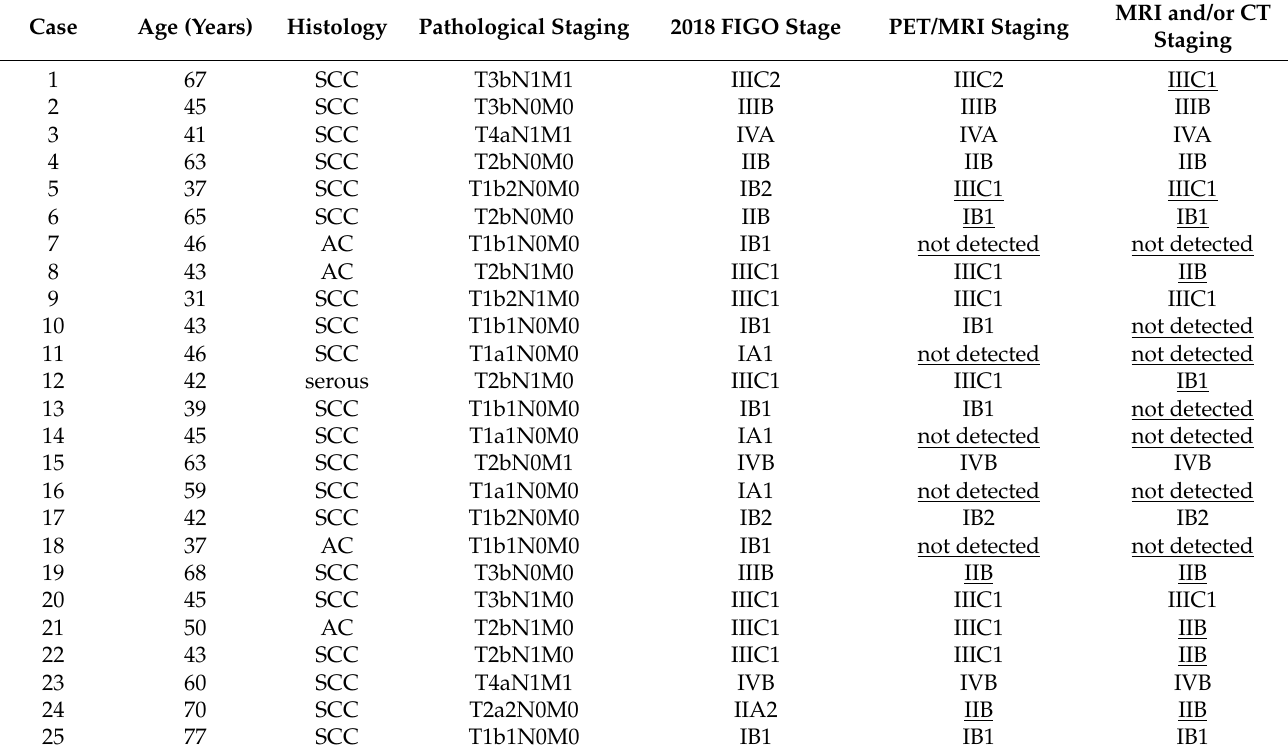
Table 1. Characteristics of patients with primary uterine cervical